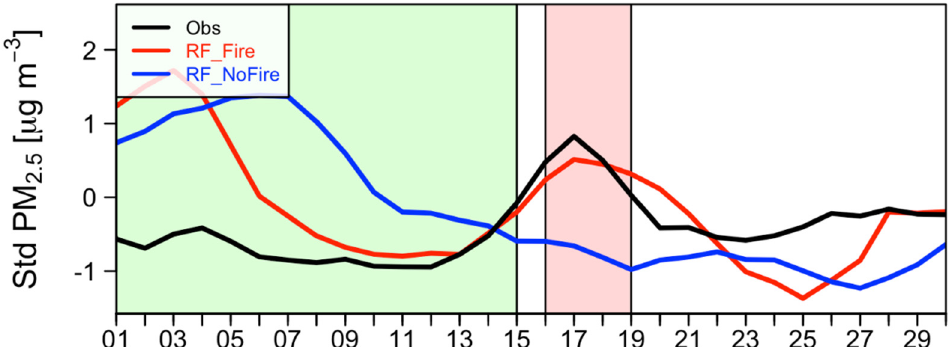
Figure 7. Time series (3-day moving averages) of observed and predicted PM 2.5 concentrations during April 2020, standardized by subtracting the mean and dividing by the standard deviation. Predictions come from the RF model with (RF_Fire) and without (RF_NoFire) including fire data as explanatory variables.